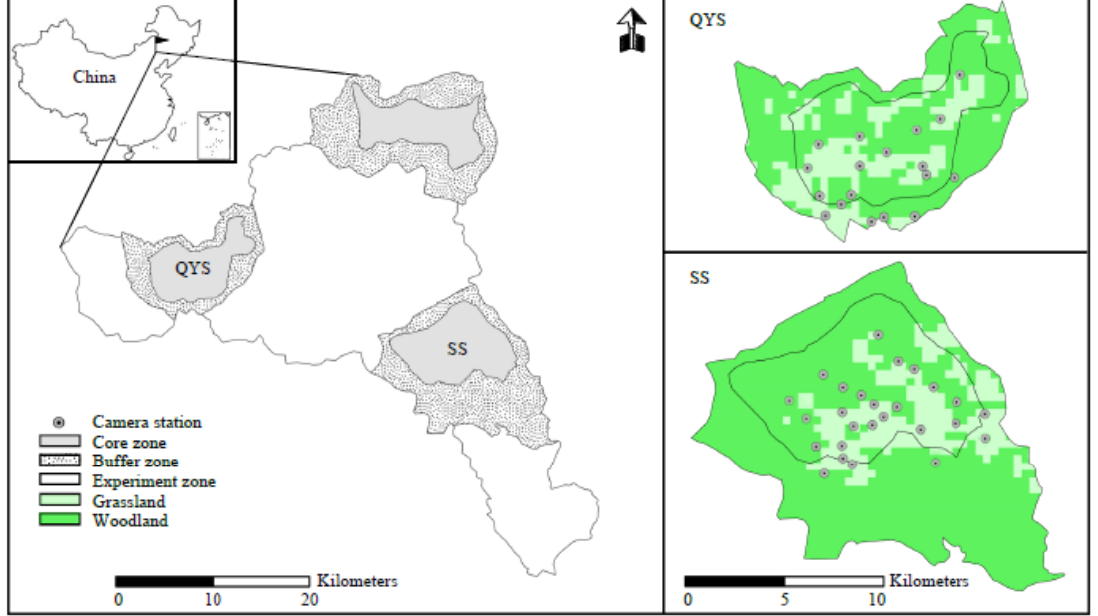
Figure 1. Location of the Saihanwula nature reserve and camera trapping sites.